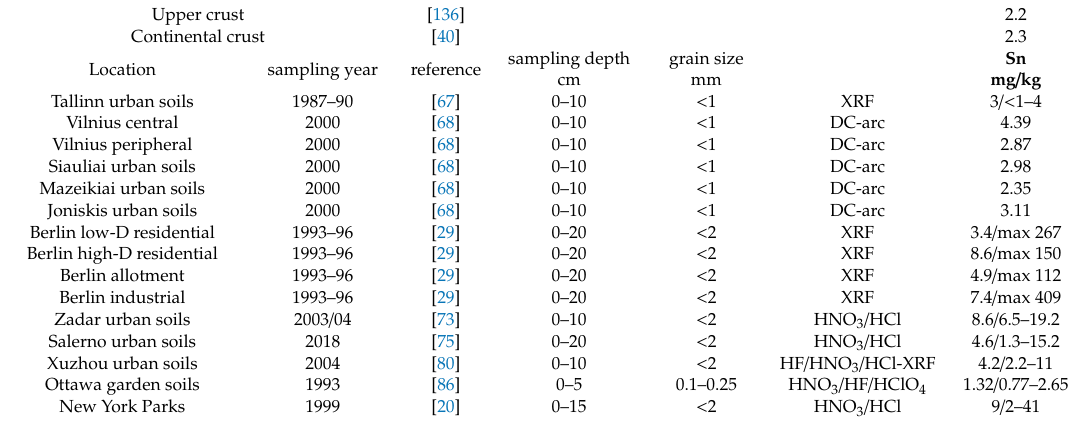
Table A18. Tin in urban soils.